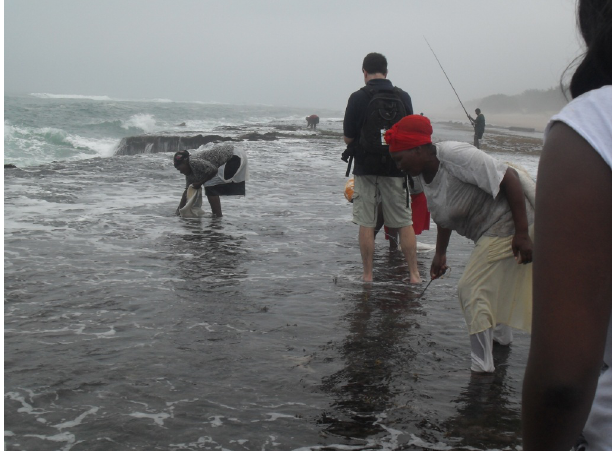
Fig. 3 . Gathering mussels along the KwaZulu-Natal coast. Photo credit: J